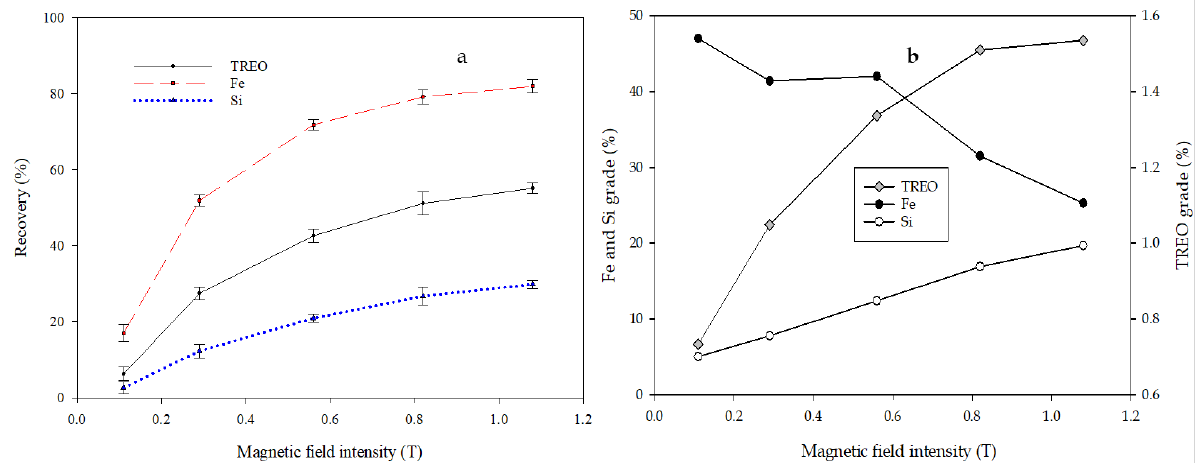
Figure 5. Effect of applied magnetic field intensity on TREO, Fe, and Si recovery from the tailings modified after Abaka-Wood et al. [44].